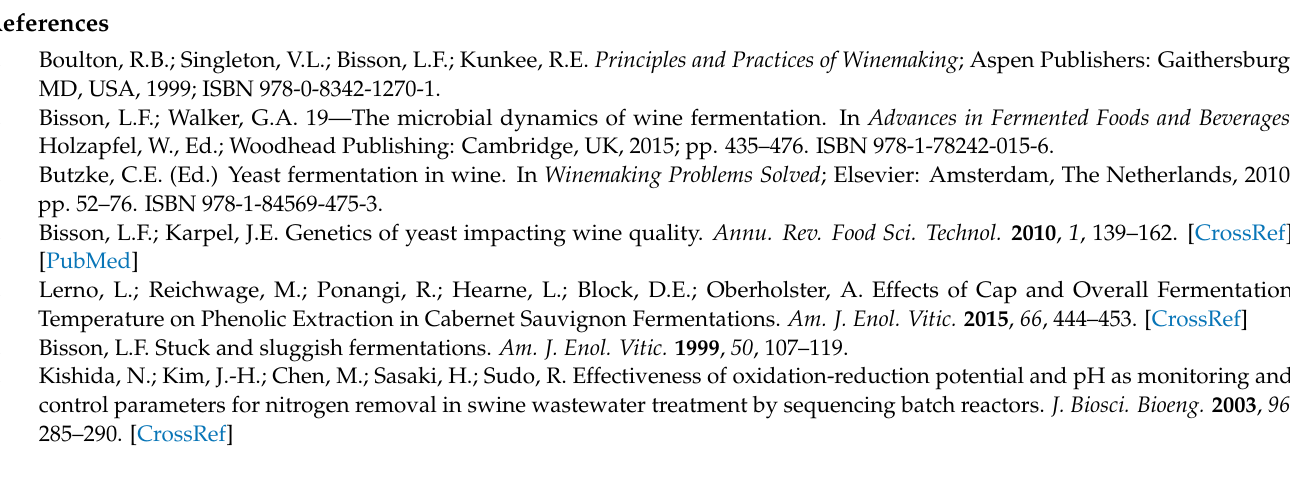
Conflicts of Interest: The authors declare no conflict of interest. Sample Availability: Samples are not available from the